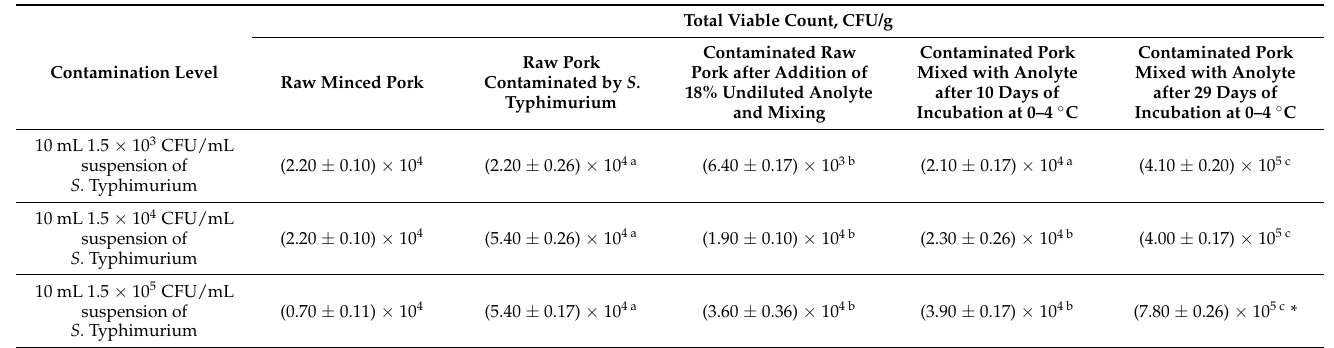
Table 7. Effect of anolyte on the total viable count of minced pork contaminated by S.